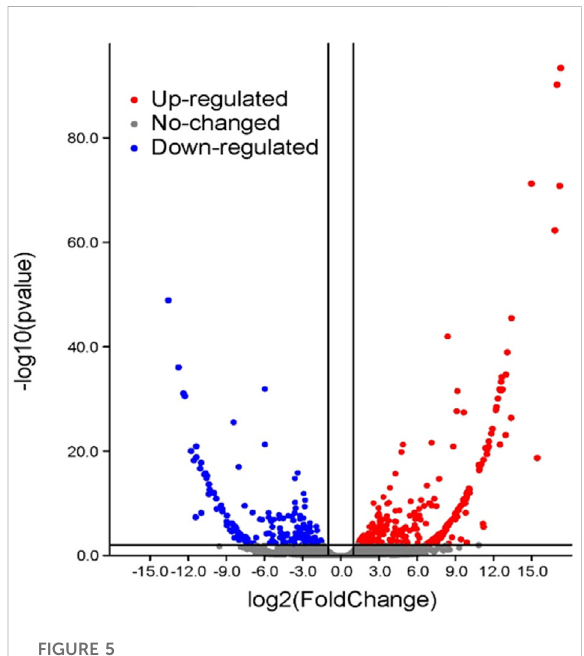
FIGURE 5 Volcano plot between NIL176 and Guichao 2. After cold- treatment, there are a total of 717 signi fi cantly differentially expressed genes in NIL176 compared with Guichao 2, including 432 up-regulated genes and 284 down-regulated